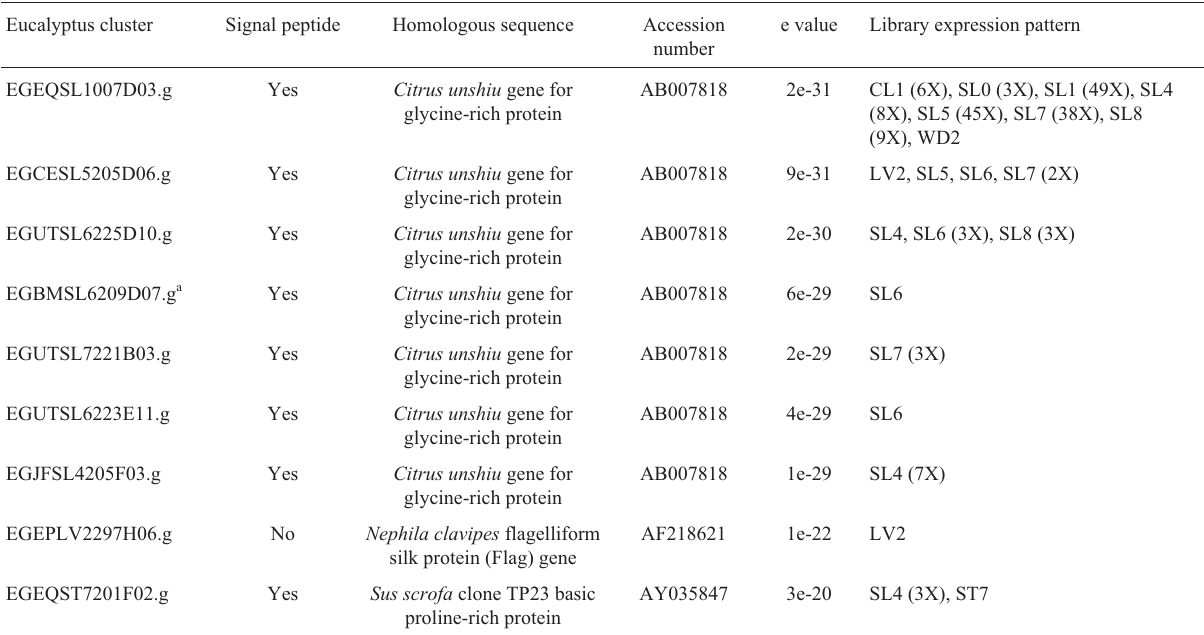
Table 3 - Eucalyptus ESTs encoding GRPs with C-terminal domains rich in